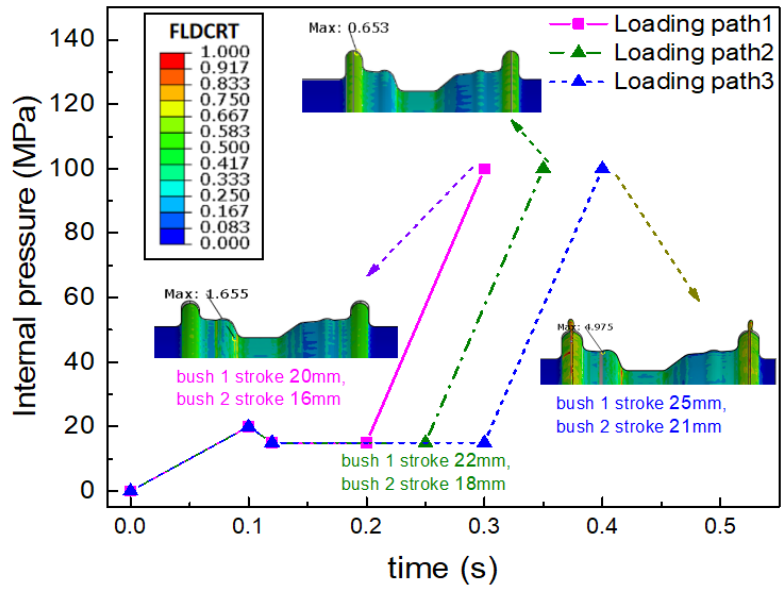
Figure 20. The forming limit results under different loading paths.